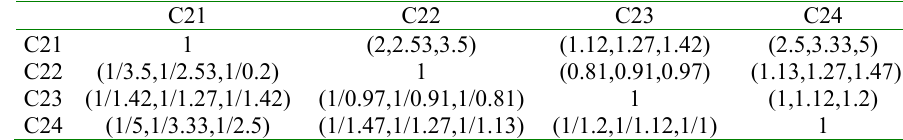
Table 19. Fuzzy aggregated evaluation matrix C2 sub-criteria